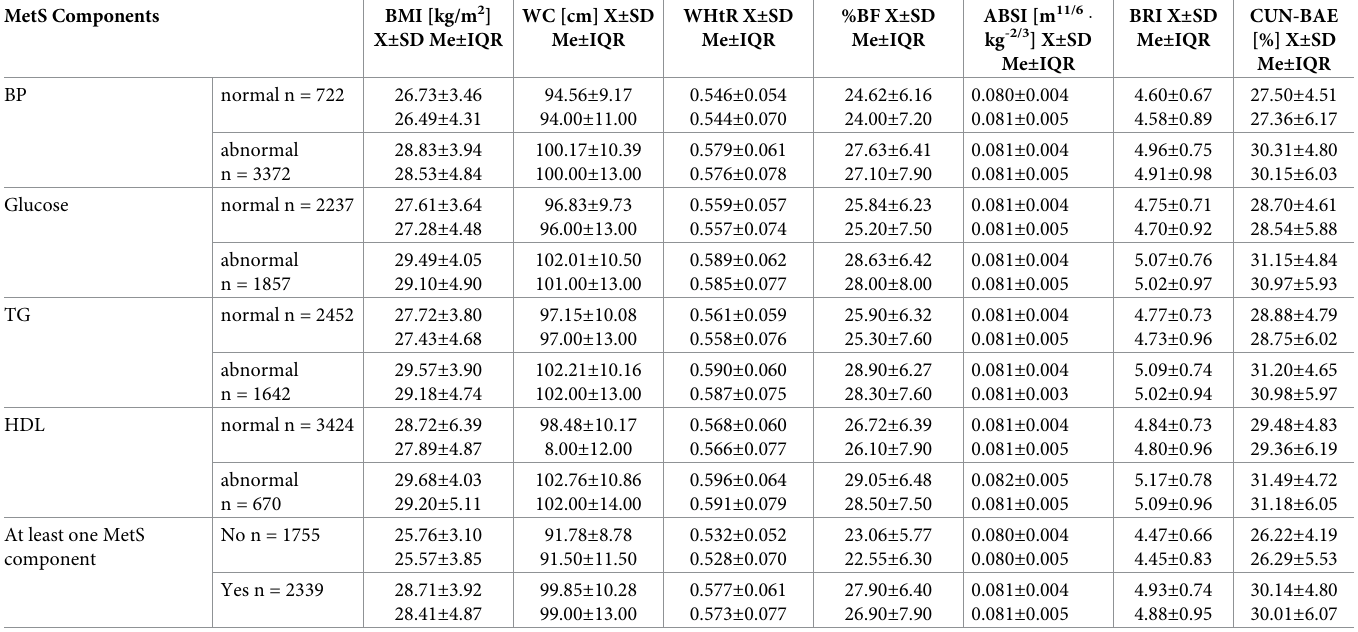
Table 1. Baseline anthropometric and laboratory characteristics of men (N =